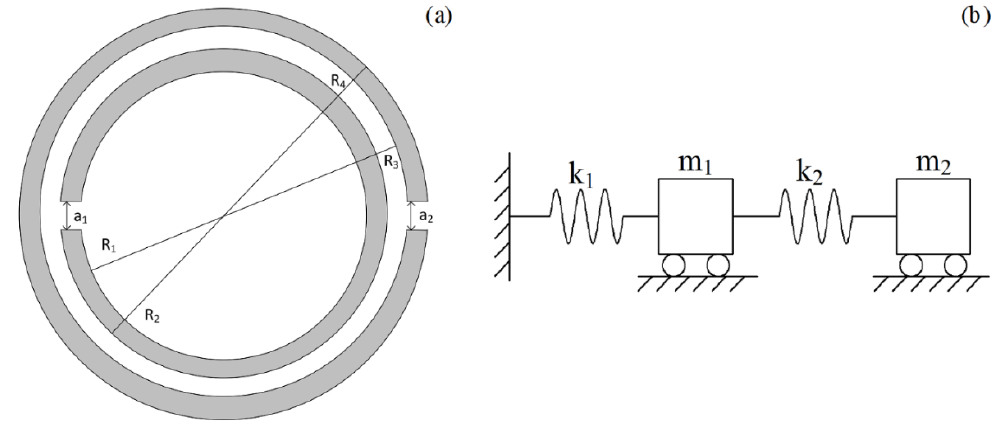
Figure 2. ( a ) The cross section of two-layer split hollow spheres (TLSHSs). ( b ) Schematic diagram of spring oscillators in series.